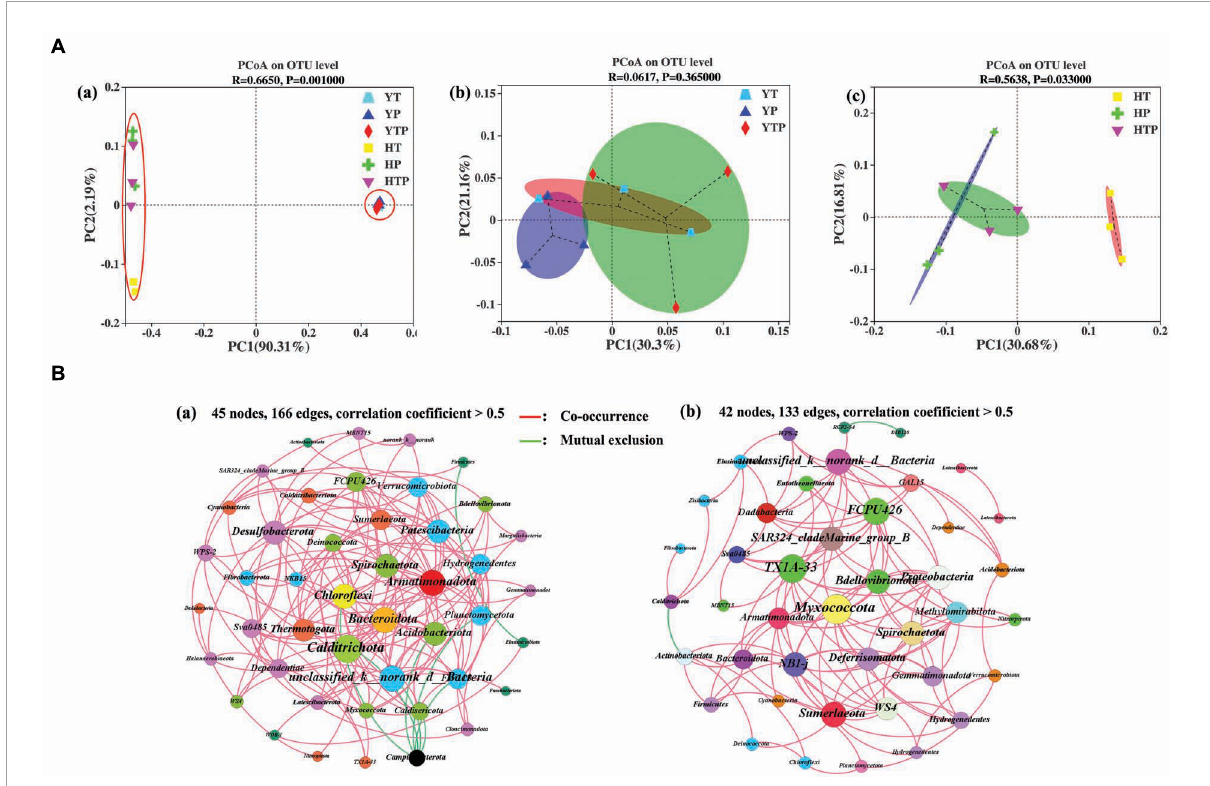
FIGURE4 Principal Coordinate Analysis (PCoA) and co-occurrence network analysis illustrates the dissimilarities and stability of microbiome. (A) PCoA illustrate dissimilarities of bacterial communities’ structure, (a) refer to PCoA among two types of sediment system contain of TC, g-C 3 N 4 , TC/g-C 3 N 4 , respectively, (b) refer to PCoA of the bacterial communities in pig farm sediment system contain of TC, g-C 3 N 4 , TC/g-C 3 N 4 , respectively, (c) refer to PCoA of the bacterial communities in riverbed sediment system contain of TC, g-C 3 N 4 , TC/g-C 3 N 4 , respectively. YT, YP, YTP refer to the pig farm sediment treated with different concentrations of TC, g-C 3 N 4 and TC/g-C 3 N 4 for 30 days, respectively; HT, HP, HTP refer to the riverbed sediment treated with different concentrations of TC, g-C 3 N 4 and TC/g-C 3 N 4 for 30 days, respectively. (B) The co-occurrence network analysis of bacterial community at phylum level in pig farm sediment (a) and riverbed sediment (b) (correlation coefficient > 0.5). The nodes of each network are colored according to phylum affiliation (97%) and sized according to degree of connection. The edges connecting the nodes are represented by red lines to indicate co-occurrence interactions or green to indicate mutualistic